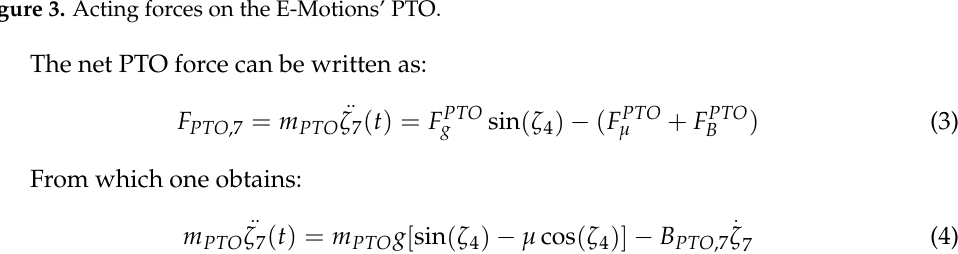
Figure 3. Acting forces on the E- Motions’ PTO.